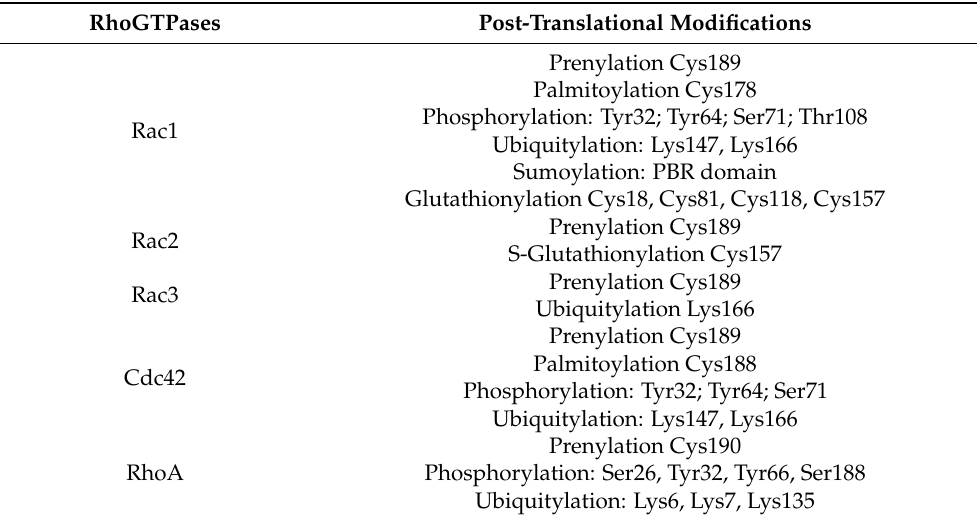
Table 1. Post-translational modifications of RhoA, Rac and Cdc42 GTPases. Cys: Cysteine; Tyr: Tyrosine, Lys: Lysine, Ser: Serine and Thr: